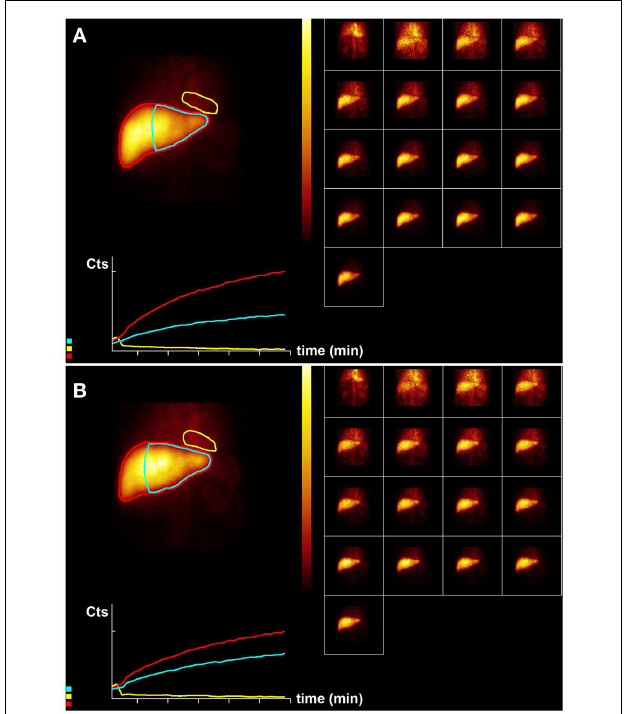
FIGURE 2 | Hepatobiliary scintigraphy before (A) and 6weeks after (B) whole liver treatment with 1.7GBq 90 Y labeled SIR-Spheres in a 65-year-old male patient with multifocal predominantly right-sided recurrent hepatocellular carcinoma (Figure 1) . Displayed are summed dynamic frames (2 × 10s/frame), a summed image (20 × 10s) with regions of interest drawn around the entire liver (red), left liver segments 2–4 (blue), and cardiac blood pool (yellow), and corresponding time–activity curves.The total liver function (body surface area corrected mebrofenin uptake rate) was reduced after treatment from 7.4 to 6.1%/min (red curves). However, function of left liver lobes 2–4 increased from 3.4 to 4.1%/min (blue).This functional increase is both relative and absolute and can be explained by insufficient post treatment functional liver capacity leading to functional hypertrophy in non-affected liver